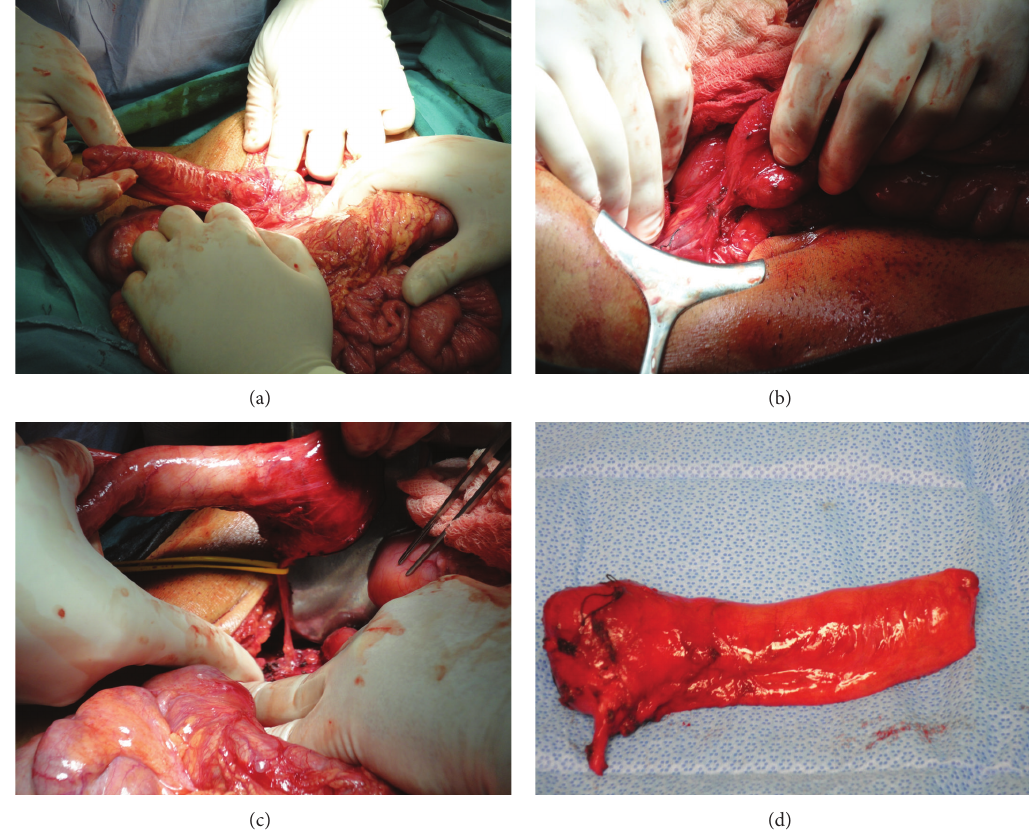
Figure 2: (a) Bowel-like cyst with no connection with the gastrointestinal tract. (b) Retroperitoneal attachment of the cyst. (c) Feeding vessels to the cyst. (d) The excised